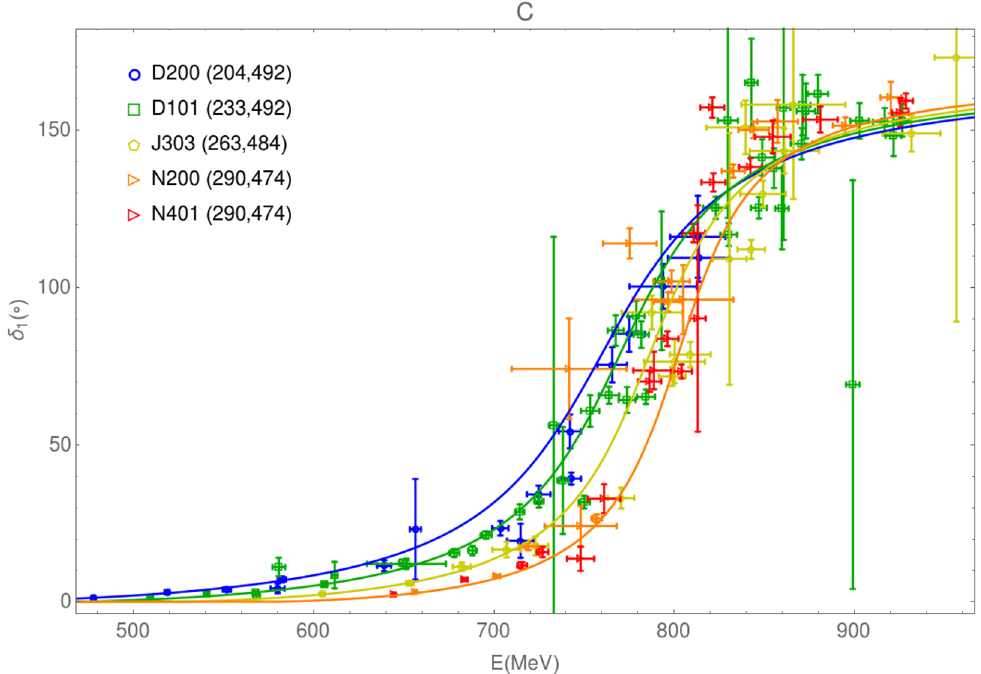
Figure 23 . Phase shift lattice data and global Fit IV solution (only the solution for the average lattice spacing is shown).